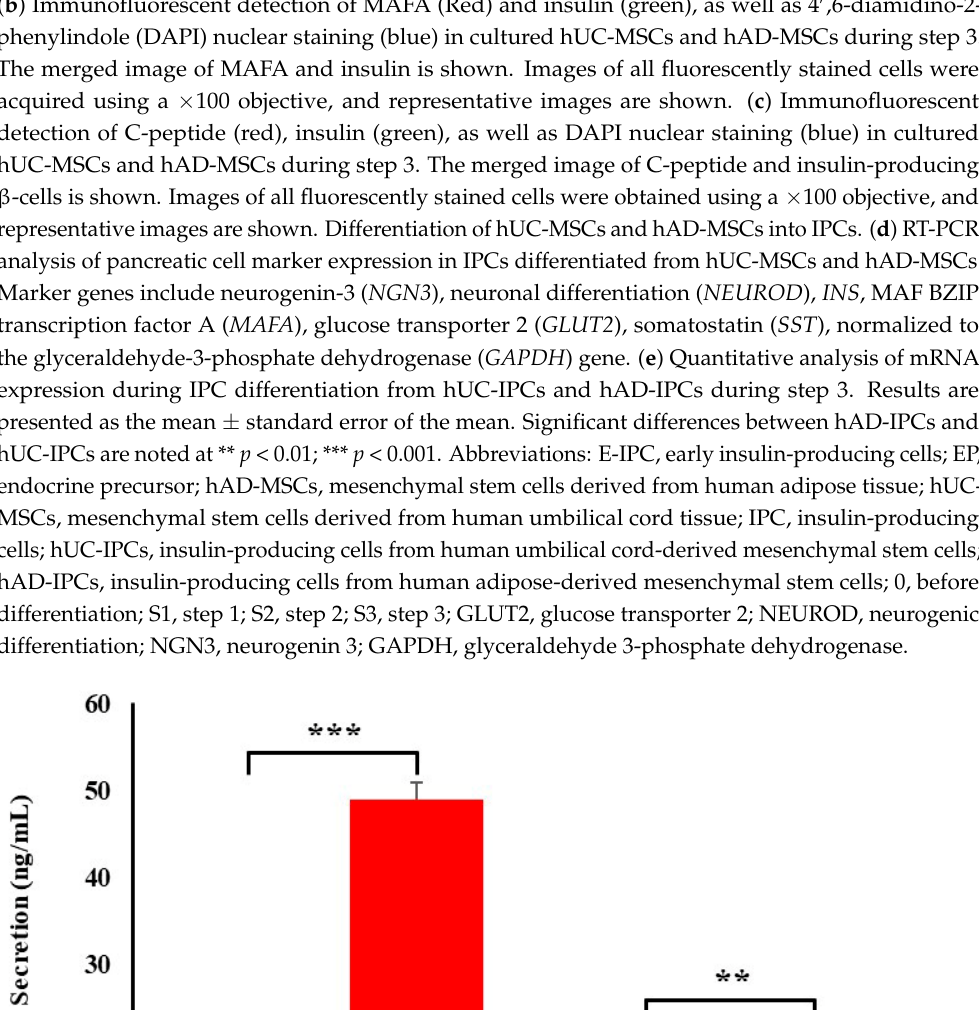
( b ) Immunofluorescent detection of MAFA (Red) and insulin (green), as well as 4 (cid:48) ,6-diamidino-2- phenylindole (DAPI) nuclear staining (blue) in cultured hUC-MSCs and hAD-MSCs during step 3.